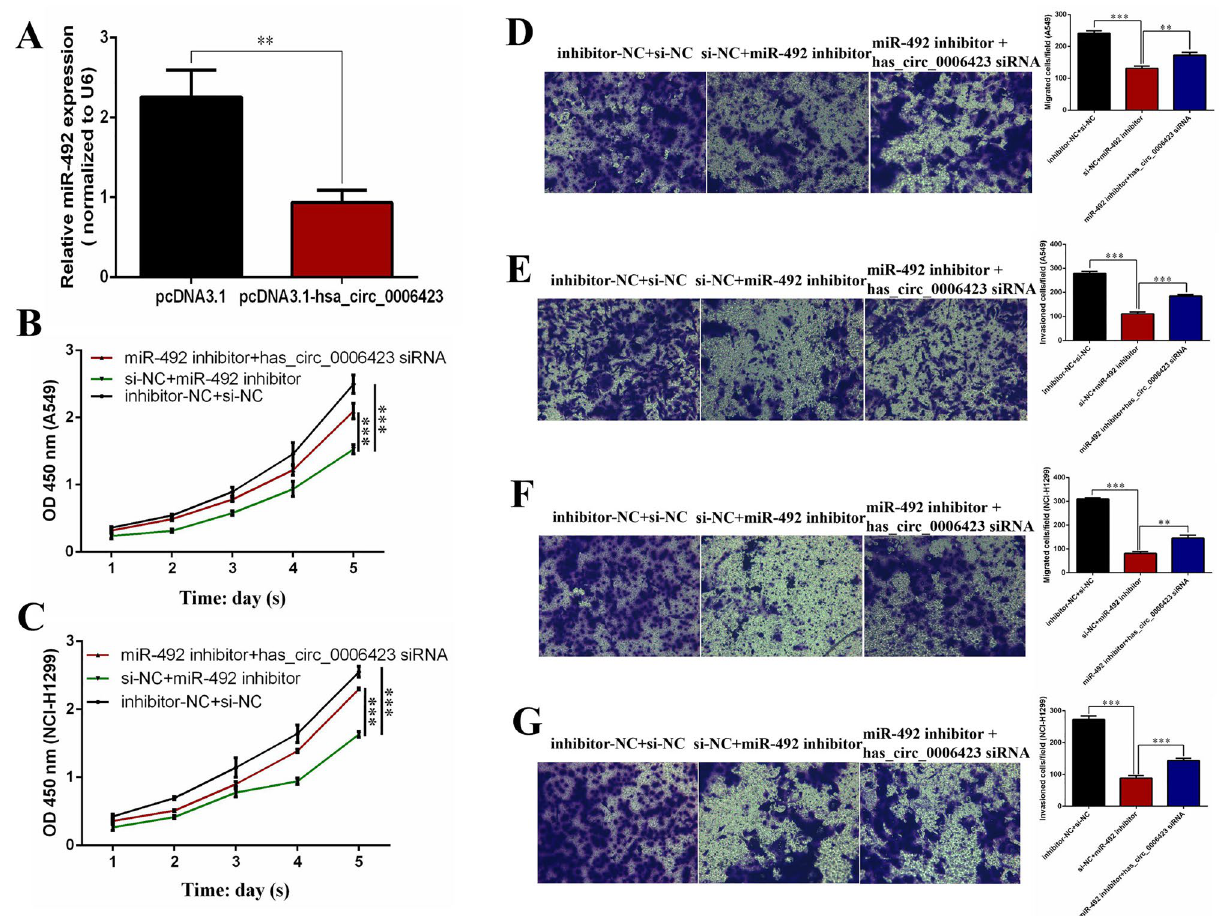
Figure 8. hsa_circ_0006423 inhibits the proliferation, metastasis, and invasion of NSCLC cells by inhibiting miR-492. ( A ) Expression level of miR-492 after transfecting miR-492 inhibitor. ( B, C ) The rescue effect